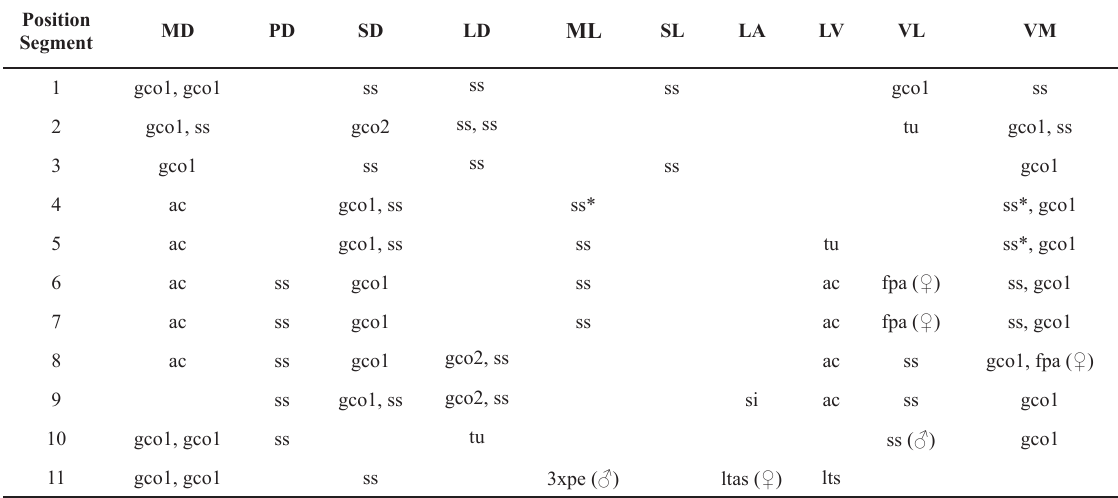
Table 10. Summary of nature and location of sensory spots, glandular cell outlets, tubes and spines arranged by series in Echinoderes pilosus Lang,